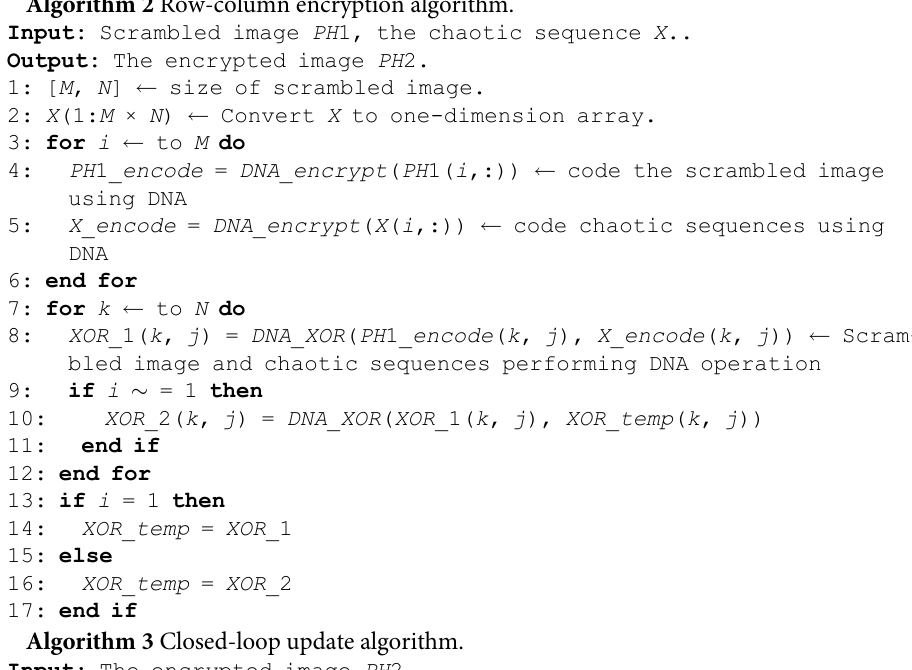
Algorithm 3 Closed-loop update